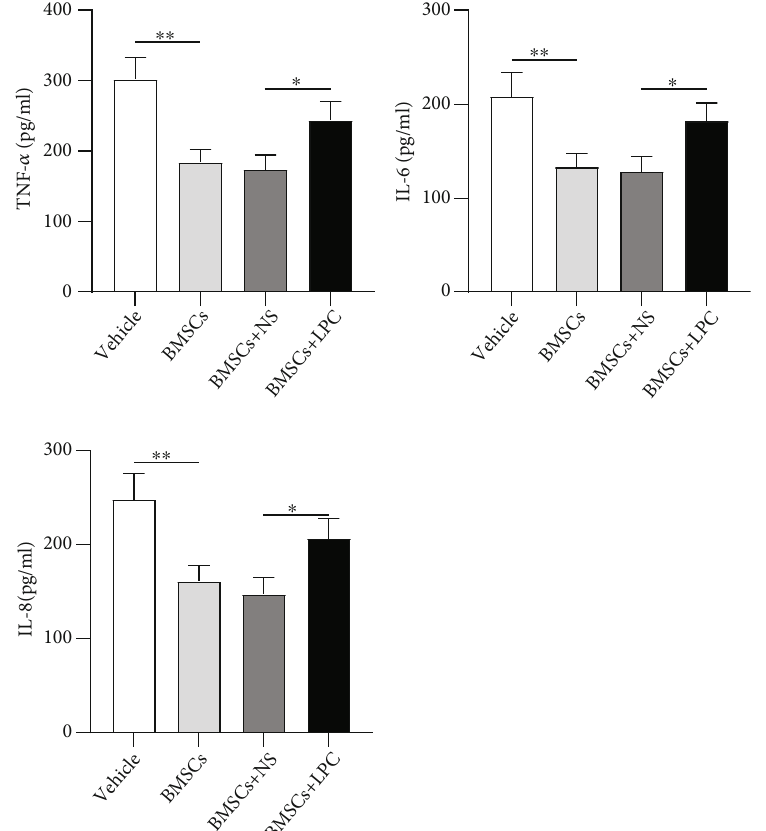
Figure 4: LPC o ff sets the protective e ff ects of BMSCs on in fl ammatory response of HRMECs. (a) ELISA was performed to assess the content of in fl ammation factors IL-8, IL-6, and TNF- α in BMSC-cocultured HRMECs after LPC treatment. ∗ p < 0 : 05 and ∗∗ p < 0 : 01